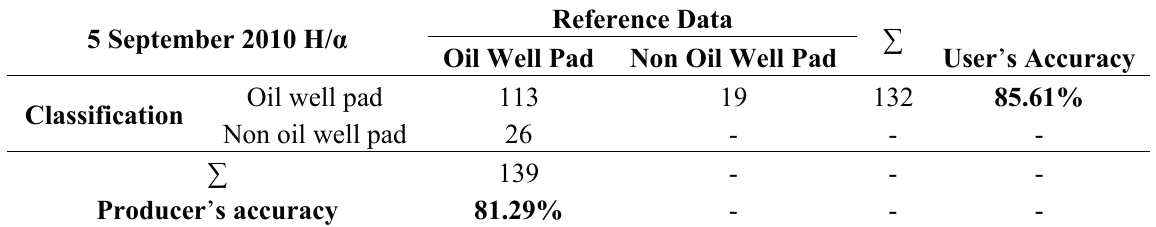
Table 3. Number-based accuracy assessment for TerraSAR-X acquisition 5 September 2010—H/ α .